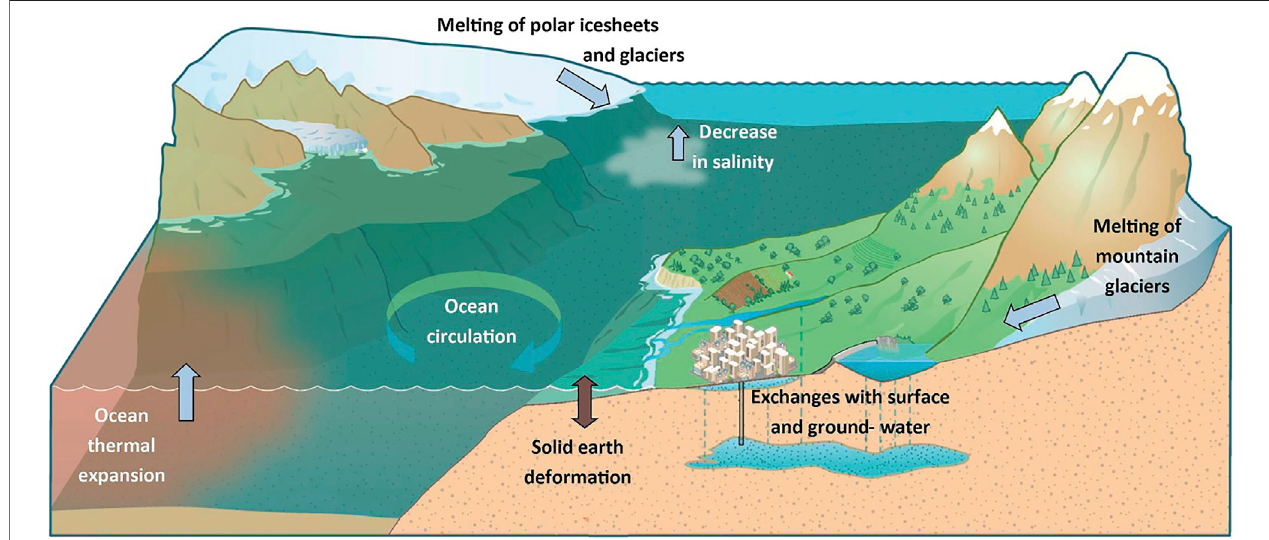
FIGURE 7 | Sketch showing the main factors causing sea level changes (Cazenave and Le Cozannet, 2013).